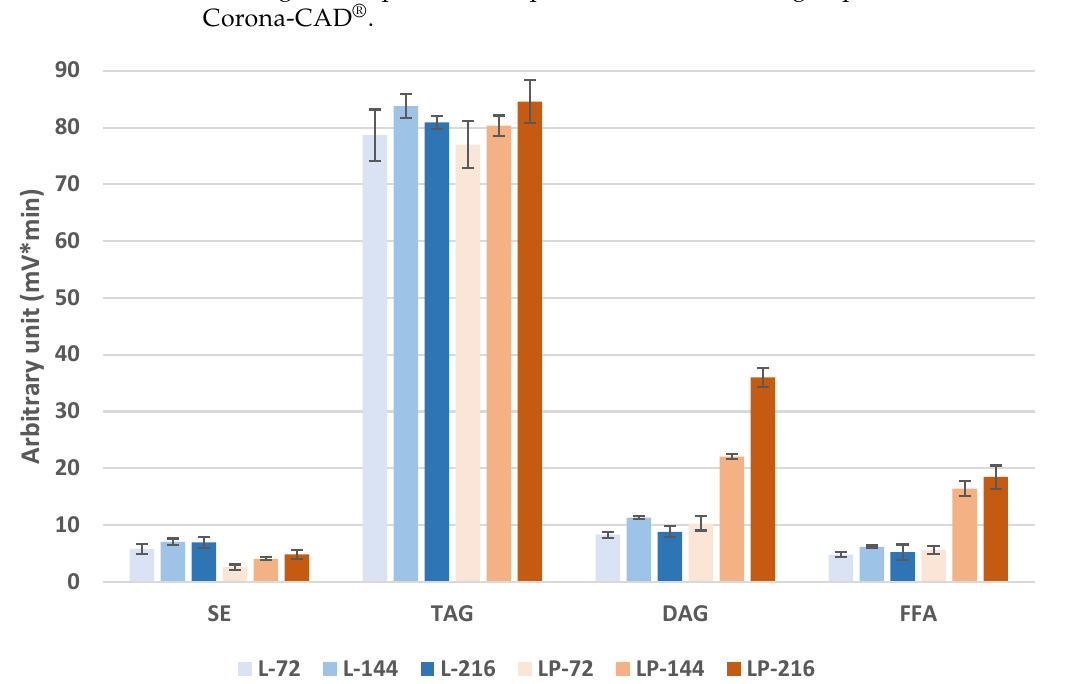
Figure 3. LC-Corona-CAD ® lipid profiles from obese L1-144 and obese LP1-144. SE—sterol esters; TAG—triacylglycerols; DAG—diacylglycerols; ST—sterols, FFA—free fatty acids; GlcCer—gluco- sylceramides; GlcADG—glycosyldiacylglycerols; PE—phosphatidylethanolamines; PA—phospha- tidic acids; PI—phosphatidylinositols; CL—cardiolipins; PC—phosphatidylcholines.